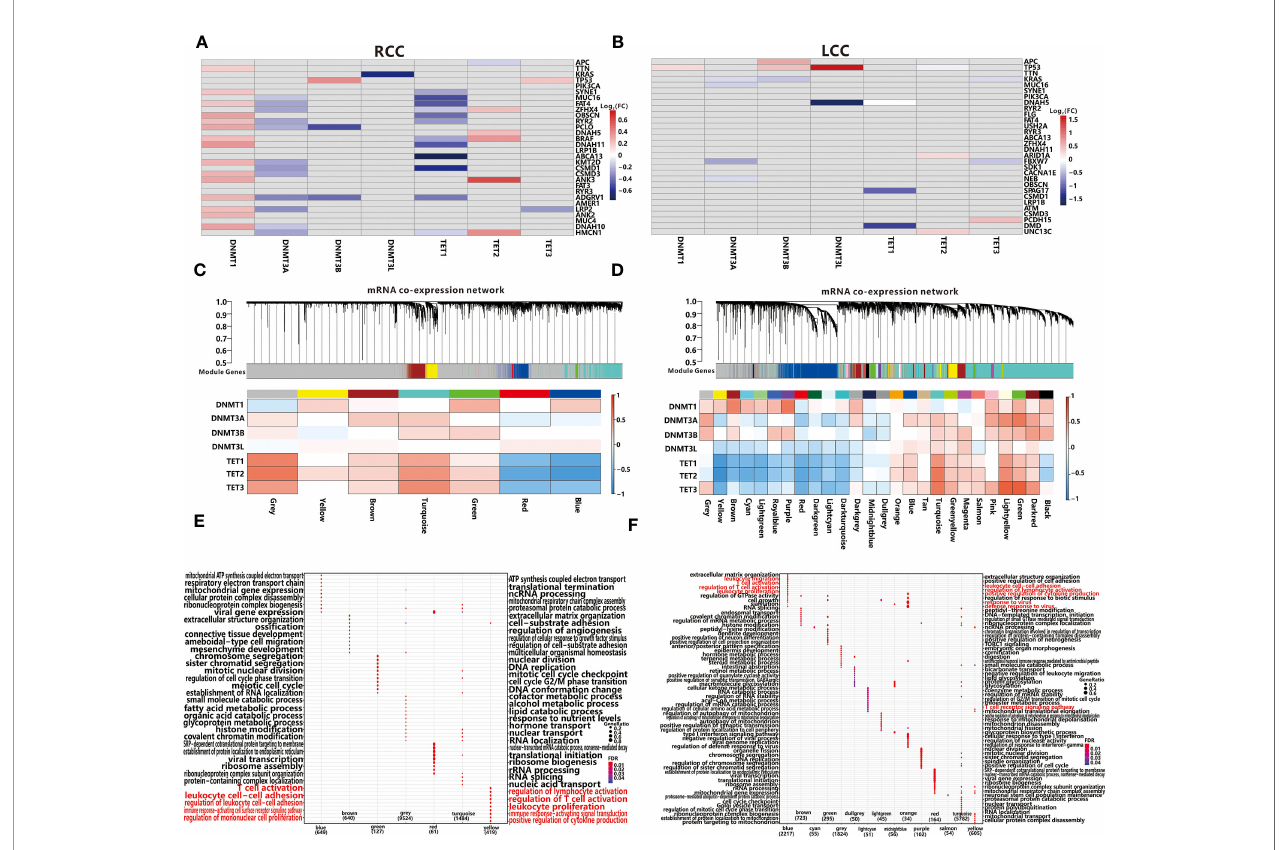
FIGURE 6 | Associations between TMGs and 7 methylation-associated genes using the Wilcoxon test in RCC (A) and LCC (B) . The grey cells represent insigni fi cant associations while the colored cells represent signi fi cant associations with p<0.05. The red color represents a higher expression in mutation group while the blue color represents a lower expression. WGCNA resolves co-expressed modules in RCC (C) and LCC (D) . Top panels describe modules de fi ned by dynamic tree cutting and the grey color represents genes not belonging to any modules. Bottom heatmaps represent associations between modules and 7 methylation- associated genes. Cells with black edge represent signi fi cant associations with p <0.05. GO functional enrichment analysis of each module in RCC (E) and LCC (F)